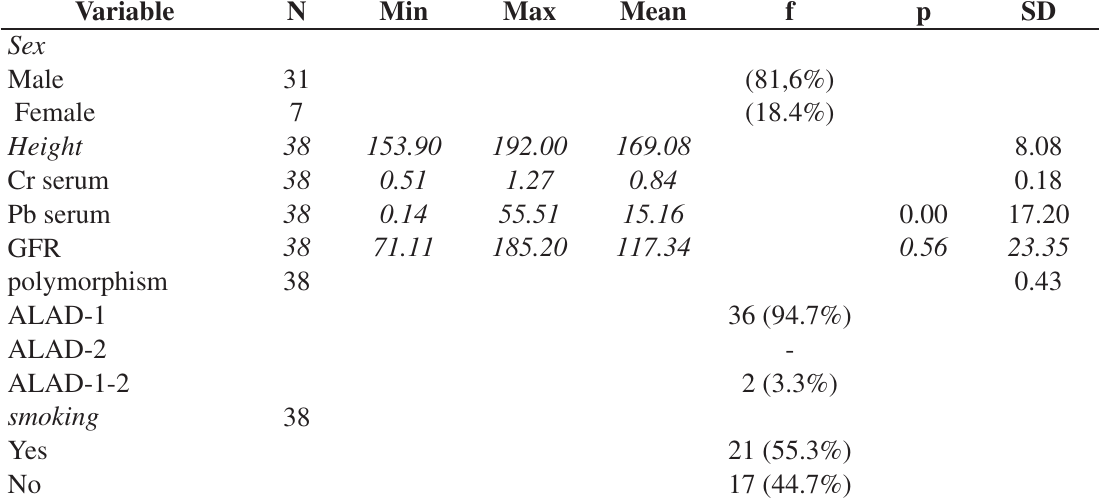
Table 1. The characteristic of respondents Variable